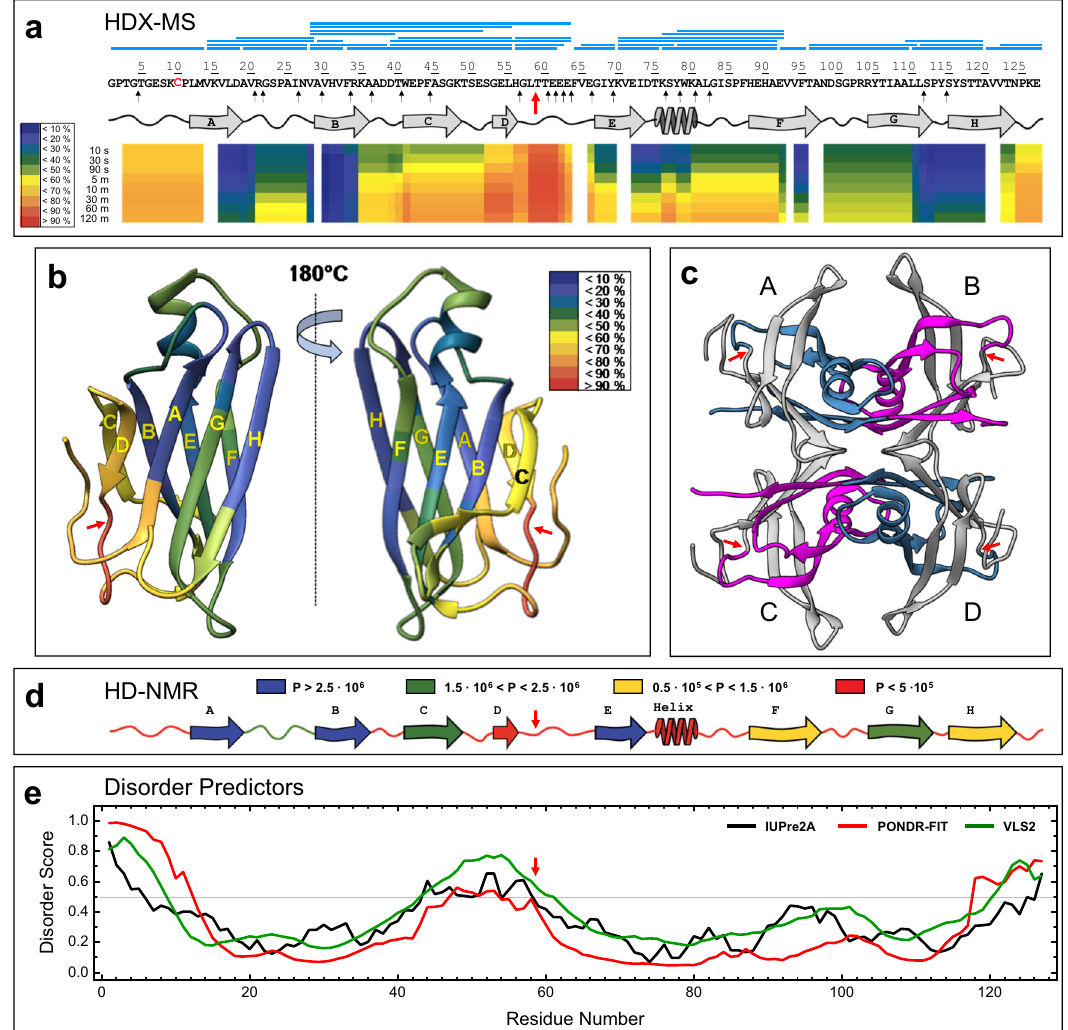
Fig. 3 HDX-MS analysis of plasma puri fi ed hTTR. a Bidimensional HDX-MS heatmap of plasma puri fi ed hTTR at pH 7.2. For each peptic fragment (blue bars), the % D value at the indicated labeling time (0.5 – 120 min) is mapped onto the protein sequence. The color key in the heatmap indicates % D , from dark blue (<10%) to light red (>90%). Secondary structure is noted at the bottom of hTTR sequence, along with a thick red arrow indicating the major scissile bond (Leu58-Thr59) for subtilisin and small black arrows indicating minor cleavage sites. The heatmap was generated using 38 single and overlapping fragments (Supplementary Fig. 5). b Three-dimensional HDX-MS heatmap of deuterium uptake by hTTR was obtained by mapping % D values reported in a (30-s H/D exchange time) onto the crystal structure of hTTR (1tta.pdb) 2 . For clarity, only the monomer structure is shown. Labels (yellow) identify β -strands while the arrows (red) indicate the scissile Leu58Thr59 bond. c Ribbon drawing of hTTR tetramer structure (1tta). The region 59 – 127 in the interacting (symmetry related) monomers are shown in blue (A, D) and magenta (B, C). The region 1 – 58 is shown in gray. d Schematic representation of HDX-NMR protection factors (P) of recombinant wild-type hTTR, after 2-h exchange time at pH 5.7 38 . The color key indicates P values: from blue ( P > 2.5 × 10 6 ) to red ( P < 0.5 × 10 6 ). Flexible/exposed and rigid/buried regions are characterized by low and high P values, respectively. e Protein disorder pro fi les of hTTR sequence, according to different prediction methods: IUPre2A 75 , PONDR-FIT 76 , and VSL2 77 proteolysis with subtilisin. The %-intensity DLS plot of a freshly prepared hTTR solution shows a major peak ( R h = 3.8 ± 1.0 nm), corresponding to the tetrameric hTTR structure (peak A) 33 , and a minor peak ( R h = 82 ± 37 nm), corre- sponding to large hTTR aggregates (peak B) (Fig. 4c). However, for >99% mass distribution, whereas peak B only for ~1% with subtilisin, there is a remarkable size redistribution of hTTR species. The size of peak A is increased ( R h = 5.1 ± 2.0 nm), while peak B disappears and a new component is gener- ated ( R h = 641 ± 465 nm), indicating the formation of much larger hTTR aggregates (peak C). Notably, after 24-h